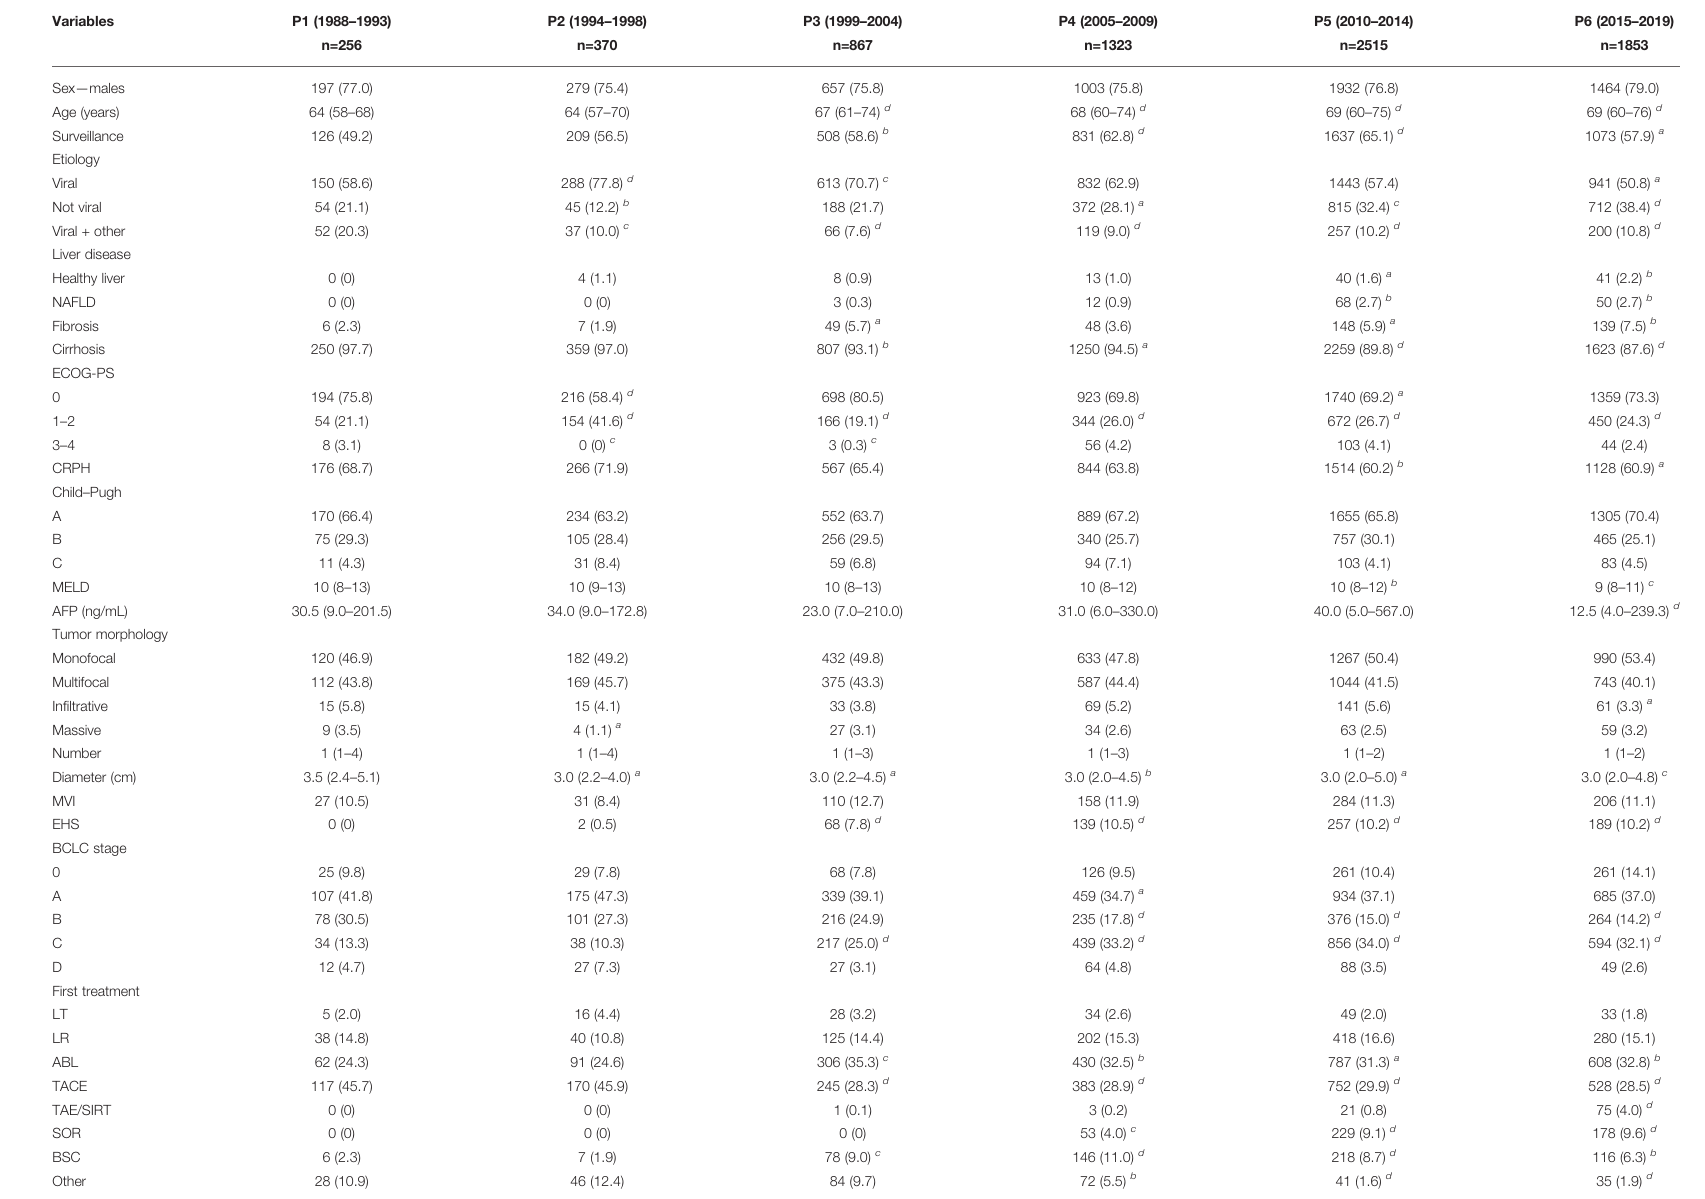
TABLE 1 | Baseline characteristics of the overall population of patients divided according to the period of